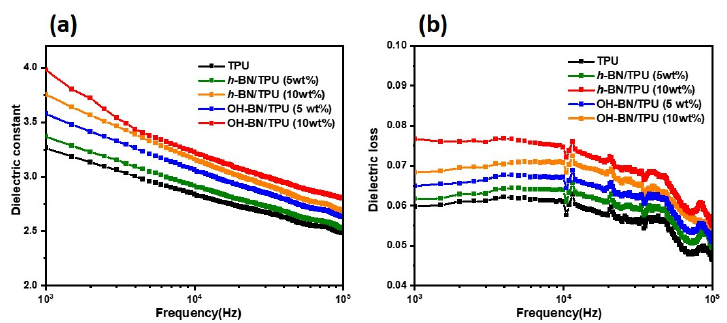
Figure 8. ( a ) Dielectric constants and ( b ) dielectric loss tangents as a function of frequency for pure TPU compared to the h -BN/TPU and OH-BN/TPU composites (at 5 and 10 wt.% filler concentrations).